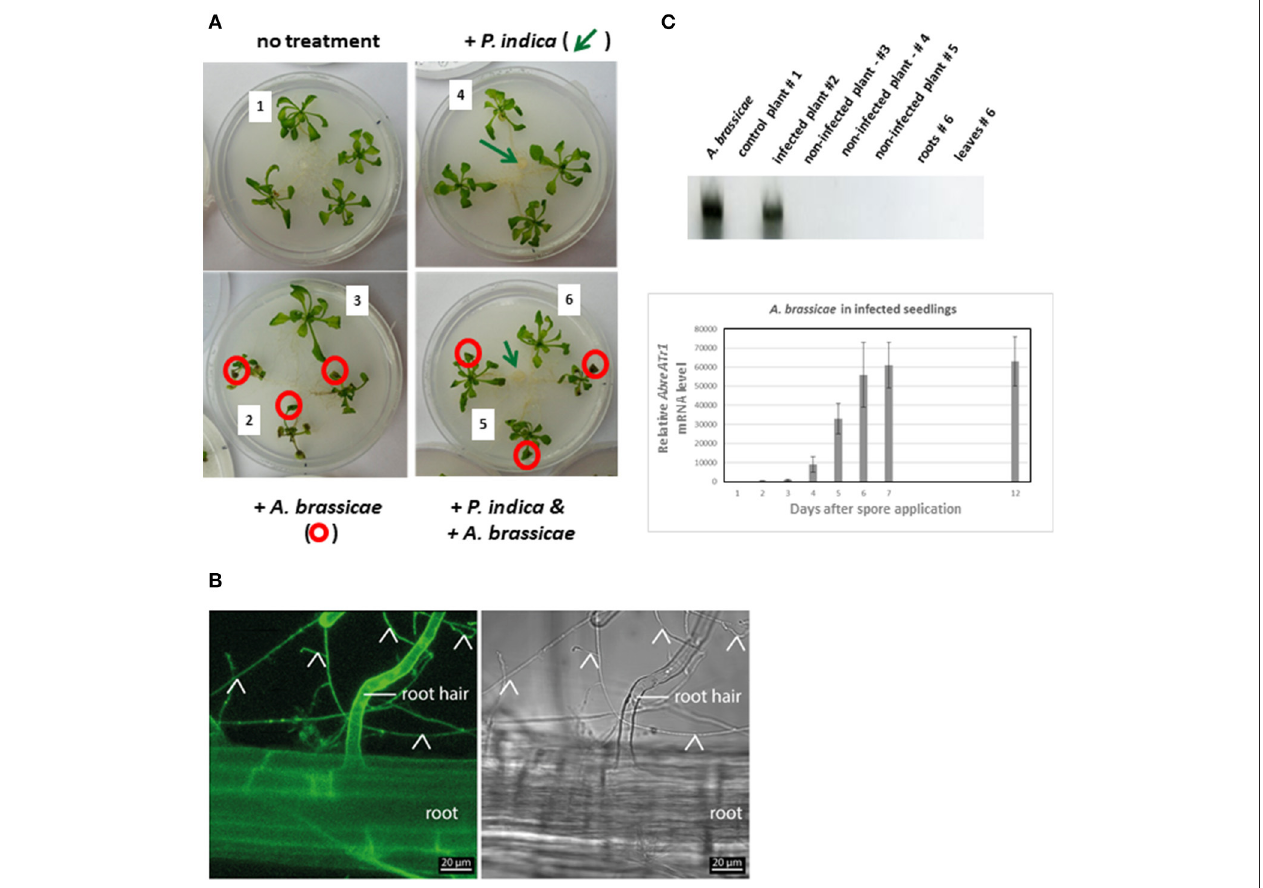
FIGURE 3 | (A) Experimental set-up for interplant communication. Four 2-week-old Arabidopsis seedlings were positioned in a fresh Petri dish. The roots were not connected (left two Petri dishes) or connected (right two Petri dishes) to each other via P. indica hyphae; P. indica was inoculated 1 week before transfer of the seedlings to the plates (cf. section Methods and Materials). The leaves of six seedlings were inoculated with an A. brassicae spore suspension (circled in red). The leaves of the seedlings 1–6 were harvested 0, 2, 5, 7, and 12 days after infection for RNA extraction and qPCR analyses. (1, no treatment; 2, A. brassicae infected material; 3, seedlings grown next to A. brassicae -infected seedlings, 4–6, as 1–3, except that seedlings were connected by a P. indica hyphal network) (B) Confocal image of an Arabidopsis root grown on the P. indica hyphal lawn for 12 days (end of experiment). The signal detected with the GFP channel is shown on the left and a bright field image on the right; root hairs are indicated by the label and fungal hyphae by arrow heads. (C) Quantification of A. brassicae AbreATr1 mRNA by qPCR. The gel shows amplified cDNA fragments from mRNAs of the seedlings #1–6 after 12 days of co-cultivation which are shown in panel A. A. brassicae : PCR product from RNA of an A. brassicae culture was used as positive control. The graph shows relative AbreATr1 mRNA levels of the infected seedlings #2 between 0 and 12 days after spore application. Based on 6 independent experiments with 10 seedlings each. Error bars are